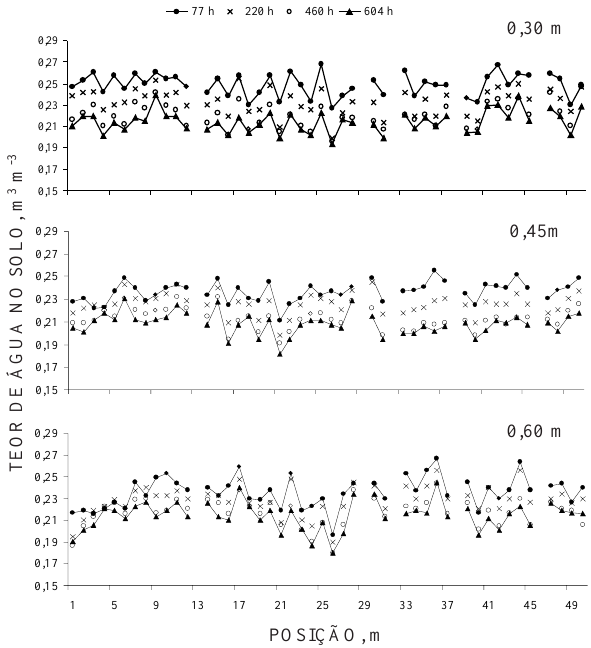
Figura 2. Variabilidade do teor de água no solo (m 3 m -3 ), segundo uma transeção de 50 pontos espaçados de um metro, em três profundidades e quatro tempos de amostragem. A linha interrompida indica os cinco pontos de medida que foram eliminados.